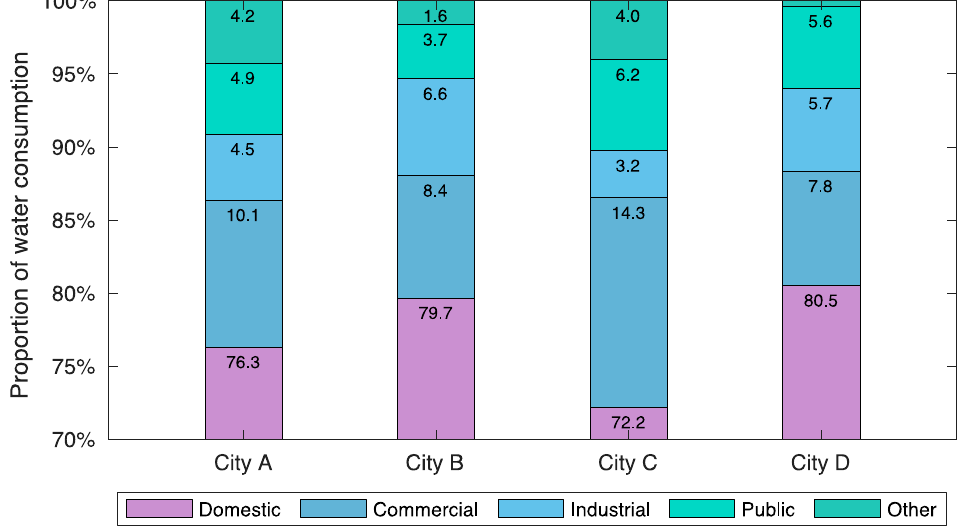
Figure 2. Distribution of water consumption for domestic, commercial, industrial, and public categories in the four case studies.